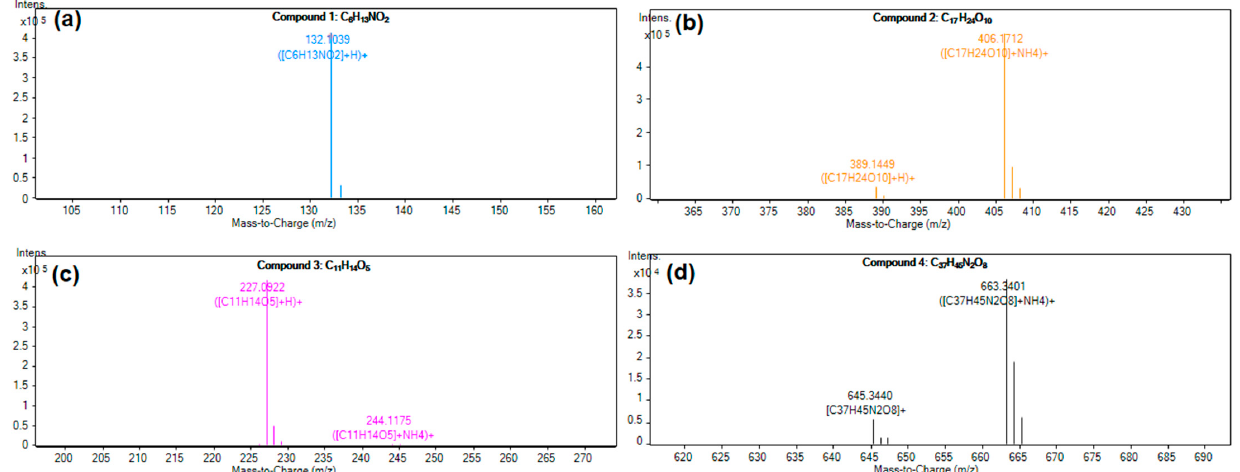
Figure 6. Secondary MS spectra of four compounds.